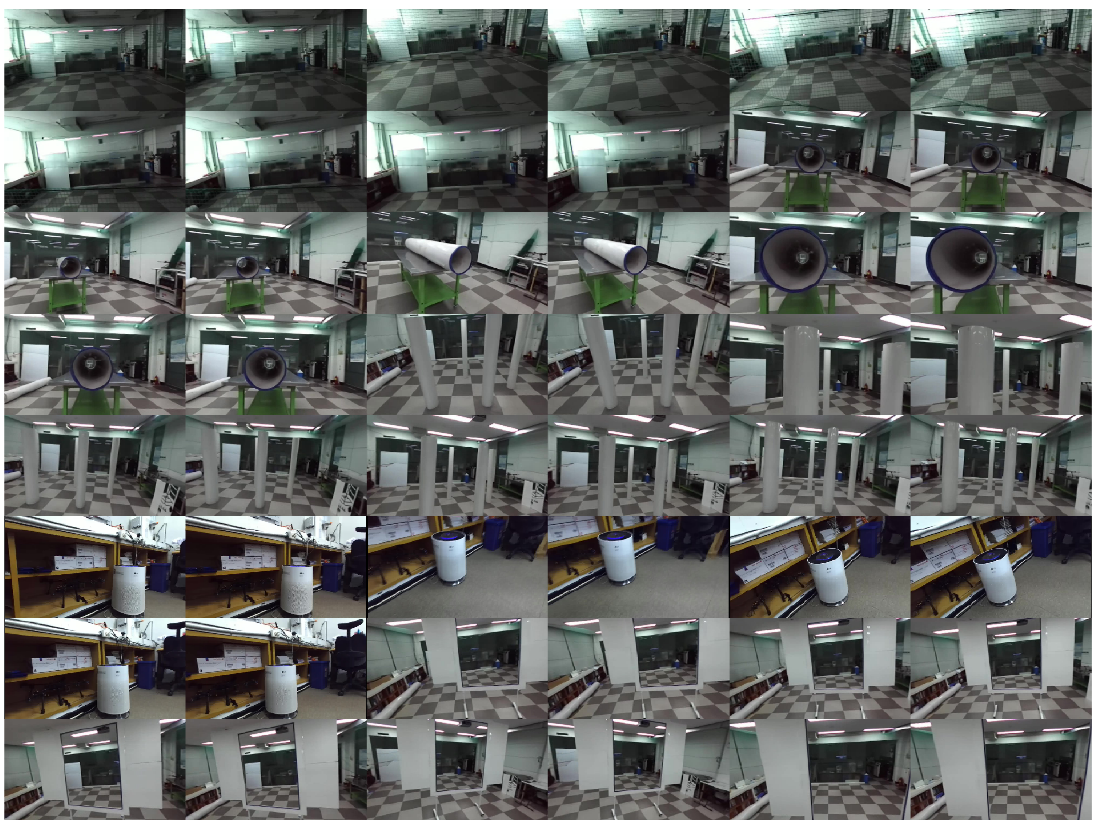
Figure 2. Sample random stereo images used to train our deep neural